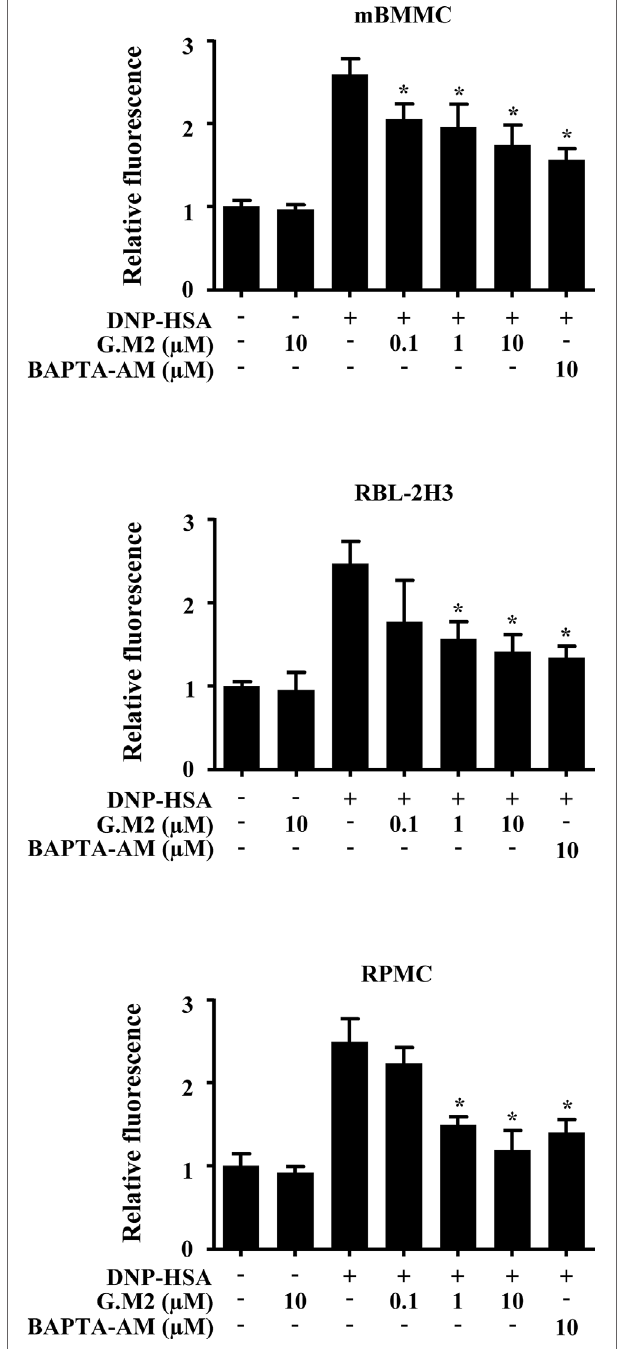
FIGURE 2 | Effects of G.M2 on intracellular calcium levels in mast cells. Anti-DNP immunoglobulin E (IgE)–sensitized mBMMCs, RBL-2H3, and RPMCs (3 × 10 4 cells/well in a 96-well plate) were pre-incubated with Fluo/3AM for 1 h, pre-treated with or without G.M2 for 1 h, and then challenged with DNP-HSA. Intracellular calcium was detected using a fluorescence plate reader. Each dataset presented as a graph represents the means ± SEM of three independent experiments. * p < 0.05, compared with the DNP-HSA- challenged